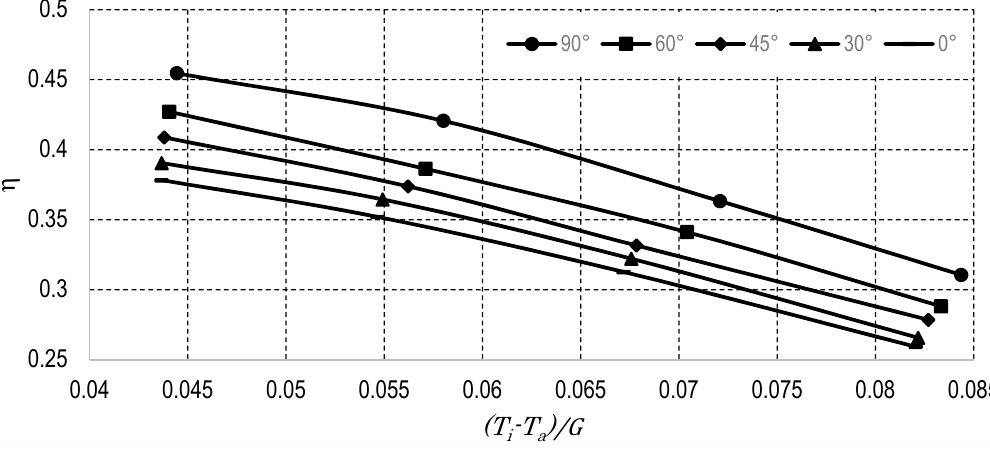
Figure 8. η vs. β and ( T i − T a )/ G .